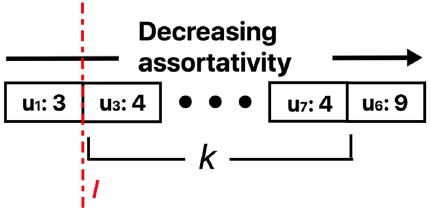
Figure 2. For each newly added node v , hash table L , where L u is the absolute difference between the degree of new node v and node u . The keys in L are arranged in the increasing order of L u . The parameter ι marks the offset that controls the level of assortativity.